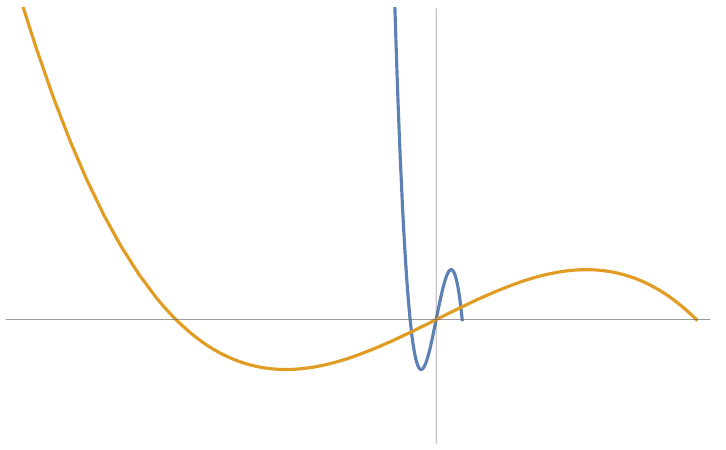
Figure 1 . Schematic picture of the effective potential in the case of g 4 (cid:28) 1 . The blue and yellow lines shows y = 1 . 0 × 10 0 , y = 1 . 0 × 10 − 1